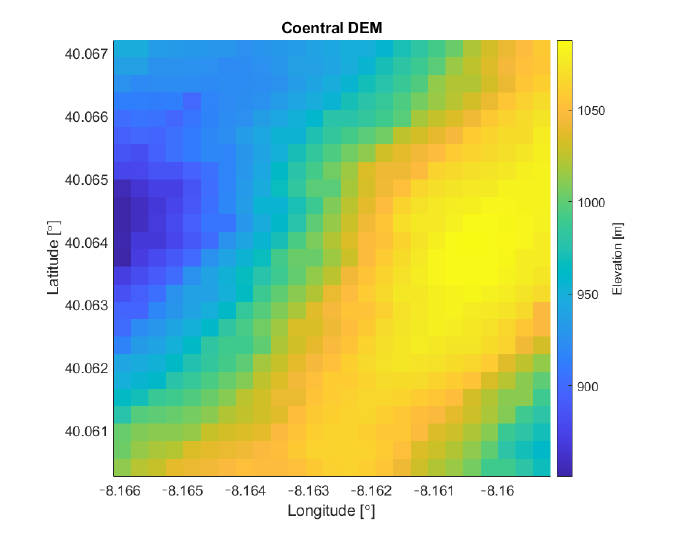
Figure 4. DEM of testing area near Coentral, Leiria . Table 3. Coentral DEM